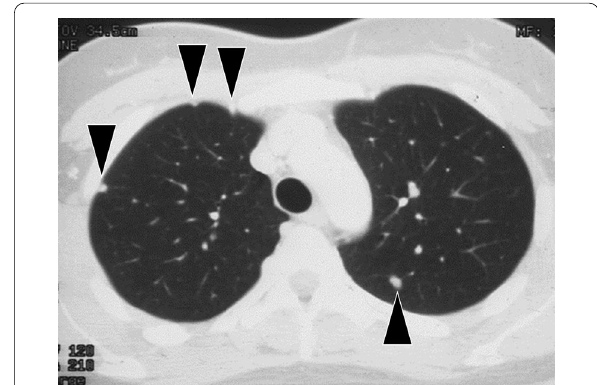
Fig. 1 Preoperative image of the first relapse. Computed tomography revealing multiple pulmonary lesions (arrows) ( a )